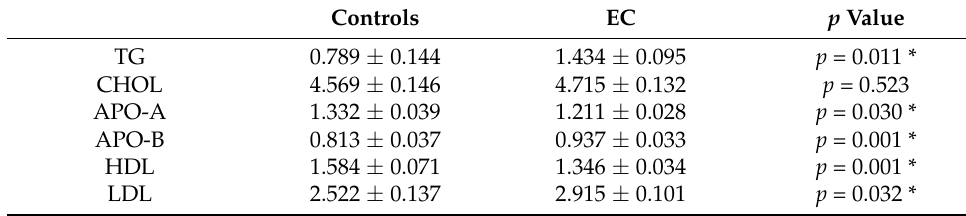
Table 3. The serum lipid levels of patients with endometrial cancer and control